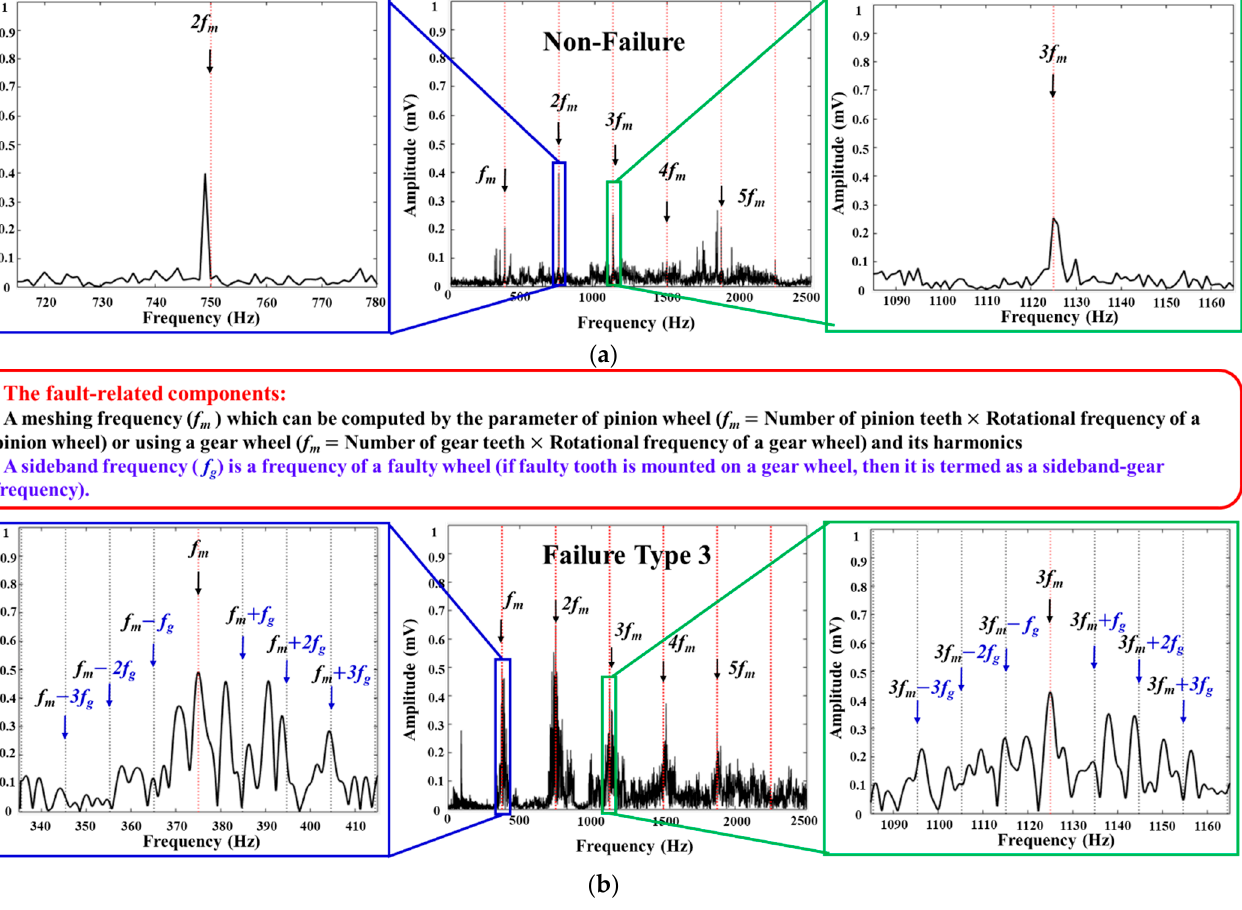
Figure 4. The frequency spectrum analysis of vibration samples acquired from the non-failure ( a ) and failure type 3 ( b ) conditions at 900 RPM.